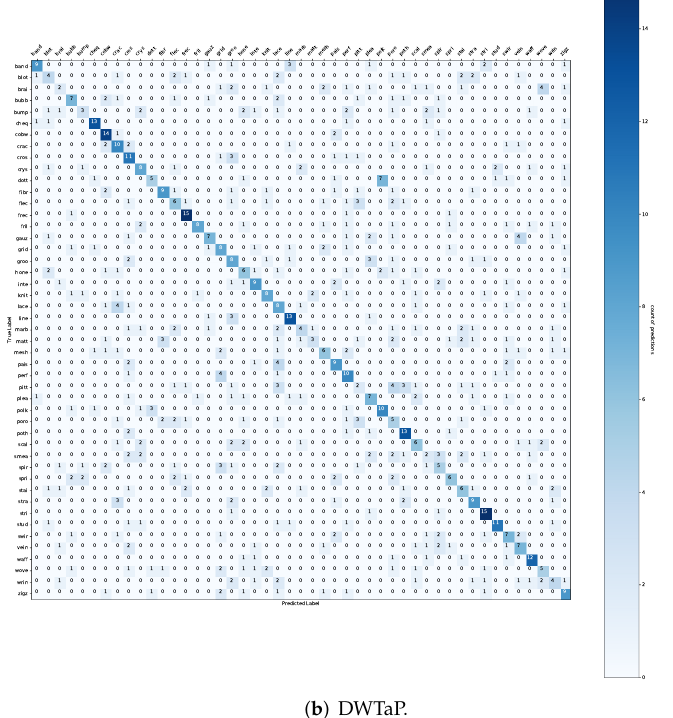
Figure A5. Experiment 2 with Adam Optimizer—the confusion matrix correlates with the two best models (MaxP and DWTaP) for the DTD dataset.